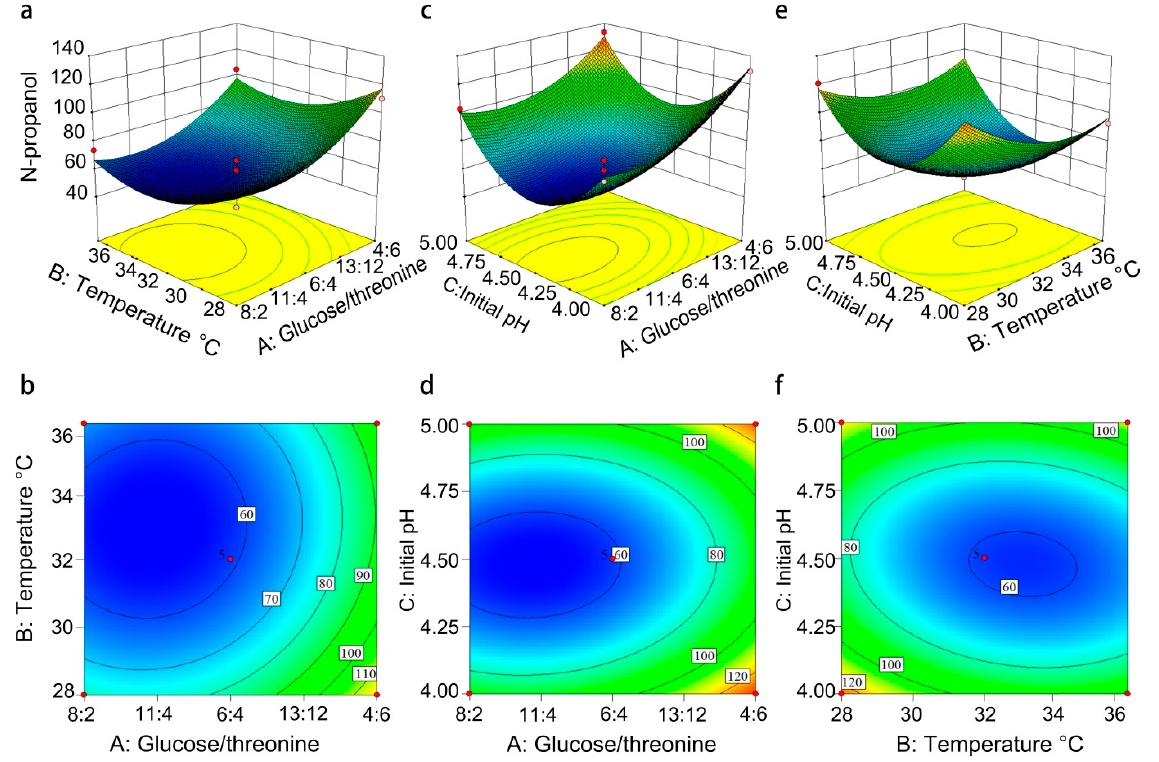
Figure 3. Response surface (3D) and corresponding contour (2D) of n-propanol production affected by the interaction of two factors. ( a , b ) Effect of the interaction of glucose/threonine ratio and temperature on the n-propanol production. ( c , d ) Effect of the interaction of glucose/threonine ratio and pH on the n-propanol production. ( e , f ) Effect of the interaction of temperature and pH on the n-propanol production.